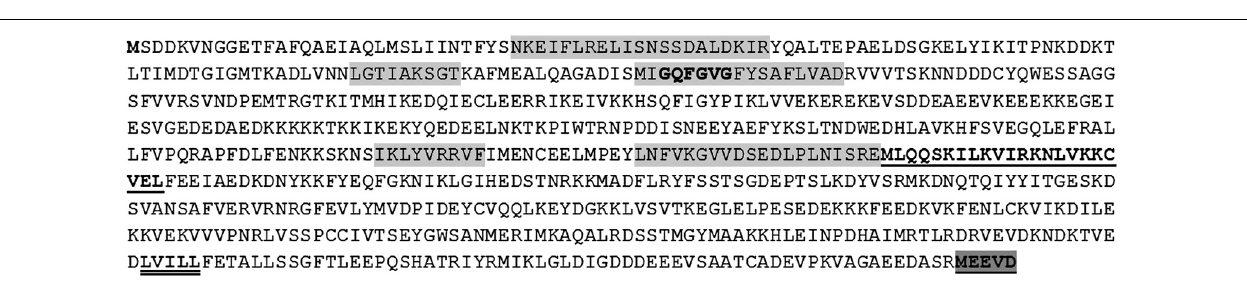
FIGURE 2 | Deduced amino acid sequence of the Hb - Hsp 90-1 of Heterorhabditis bacteriophora . The five Hsp90 signature sequences are shaded in light gray. GxxGxG motif is indicated in bold. The consensus leucine zipper sequence is double underlined. The consensus LxxLL sequence is indicated in bold underlined. The cytoplasmic Hsp90 sequence motif (MEEVD) is underlined and shaded in dark